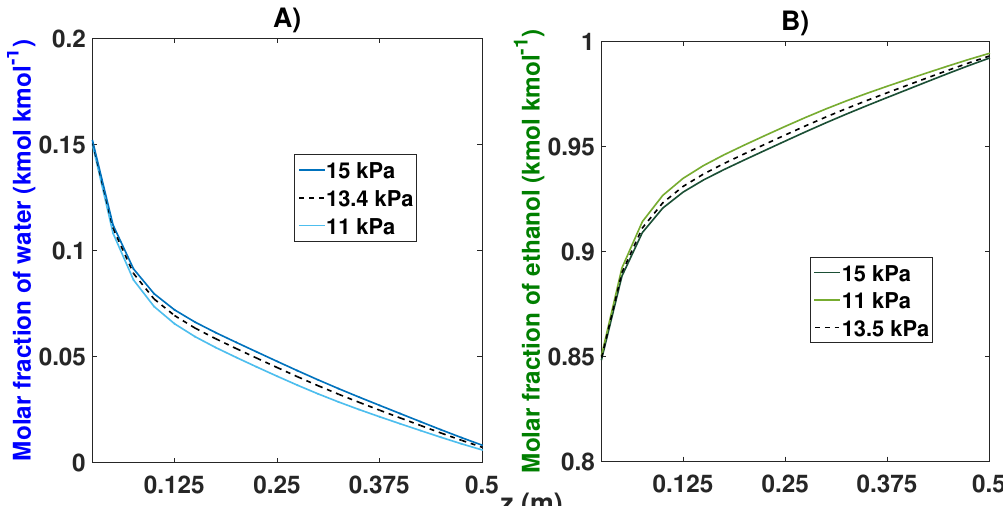
Figure 18. Molar fraction profile in the bed from the start-up and at CSS for three different purge pressures. ( A ) Effect of purge pressure on the molar fraction of water; ( B ) Effect of purge pressure on the molar fraction of